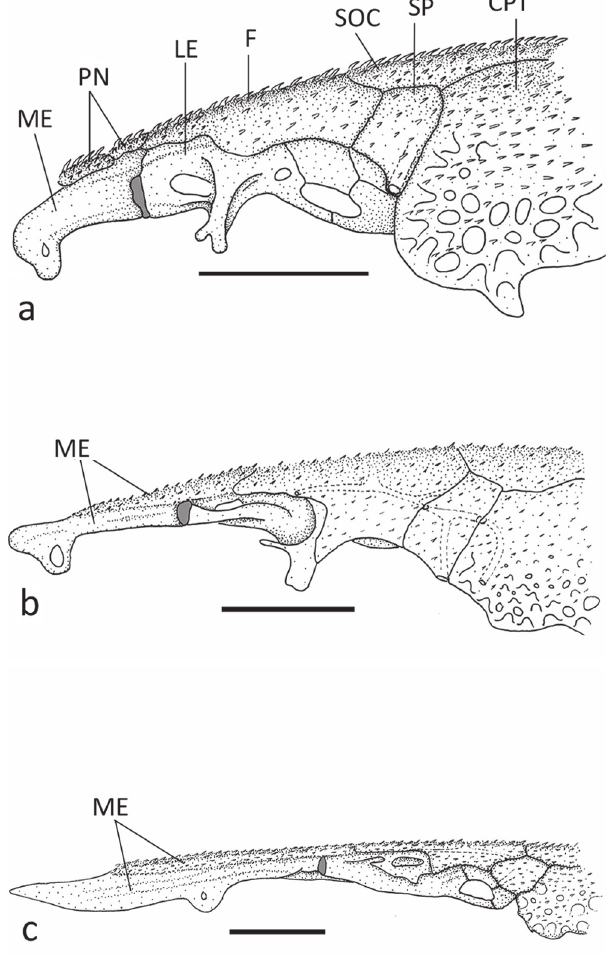
Fig. 1. Anterior portion of neurocranium of: a) Otocinclus arnoldi , MCP 25234; b) Oxyropsis wrightiana , MCP 34503; and c) Acestridium discus , MZUSP 85321. CPT = compound pterotic; F = frontal; LE = lateral ethmoid; ME = mesethmoid; SOC = parieto-supraoccipital; PN = prenasal plate; SP = sphenotic. Lateral view, left side, anterior to left. Scale bar = 2